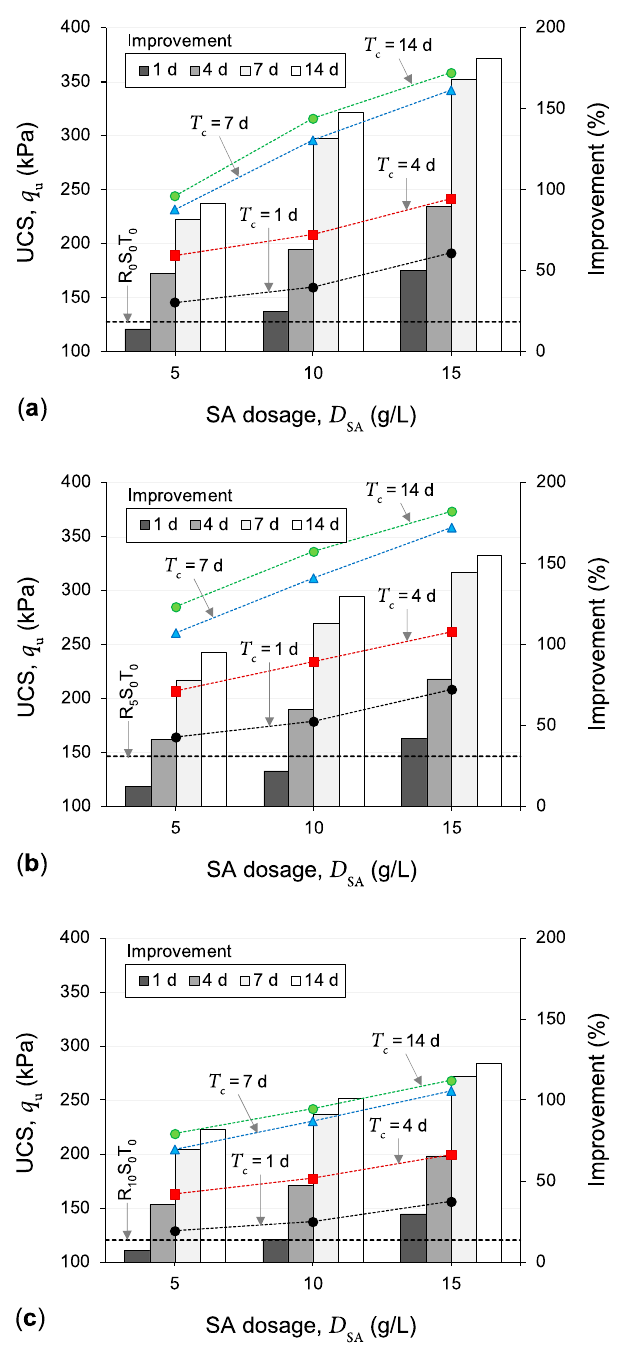
Figure 5. Variations of the UCS parameter against SA dosage for the samples ( a ) R 0 S y T z , ( b ) R 5 S y T z and ( c ) R 10 S y T z , where y = {5, 10, 15} and z = {1, 4, 7, 14}.